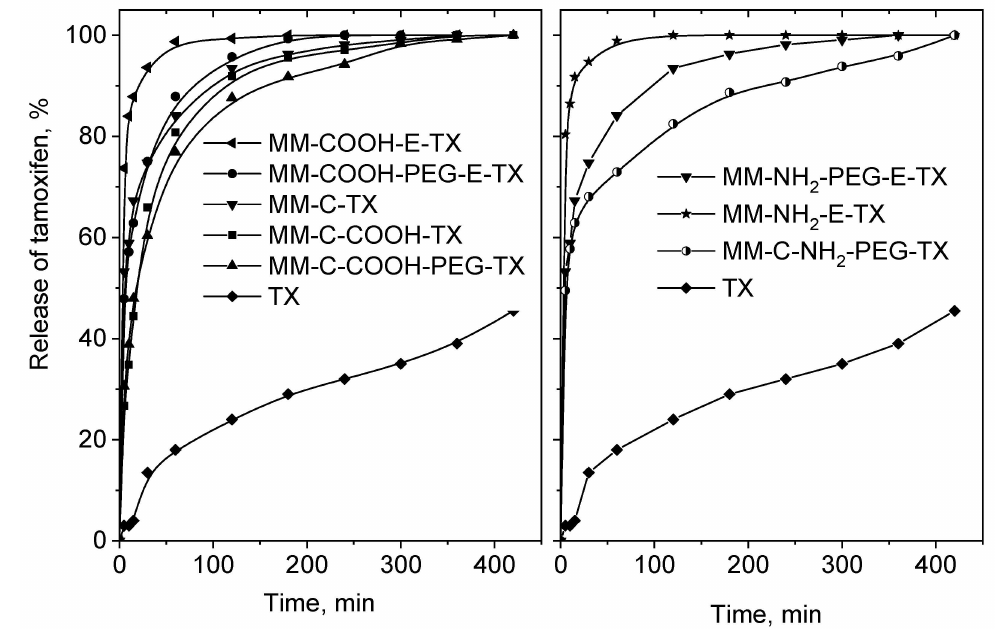
Figure8. In vitroreleaseofpuretamoxifenatpH = 7.0, andthatofthetamoxifen-loadedMMcomposites.